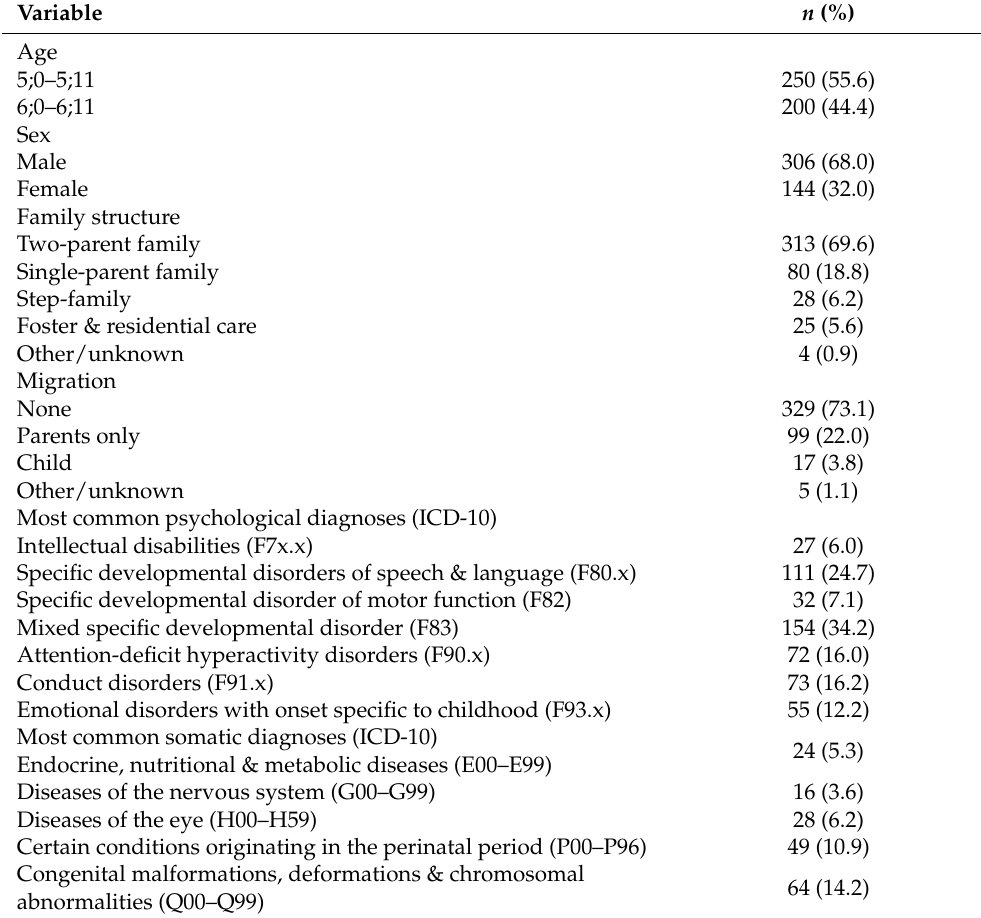
Table 2. Demographic characteristics of